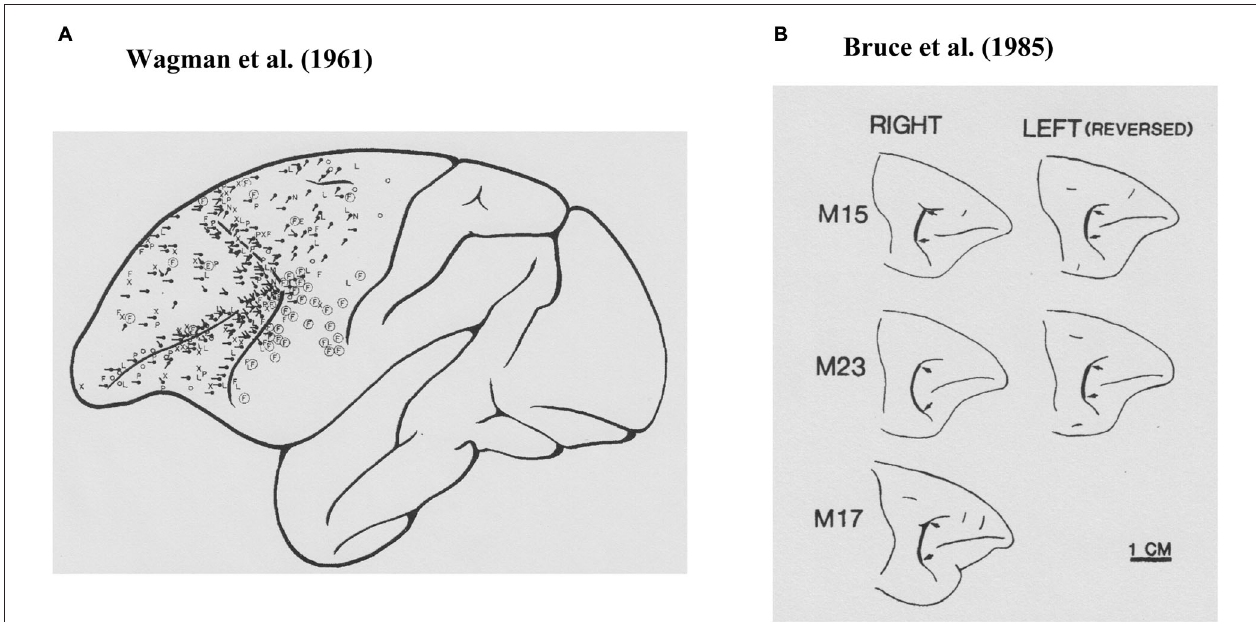
evoked saccade are shown as black lines. (B) Results from Bruce et al. (1985). Their stimulation sites were localized at the thick black lines between two